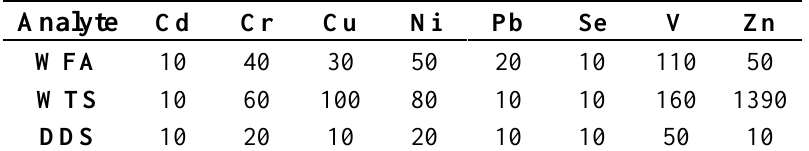
Table 3. Heavy metals content in wastes samples,